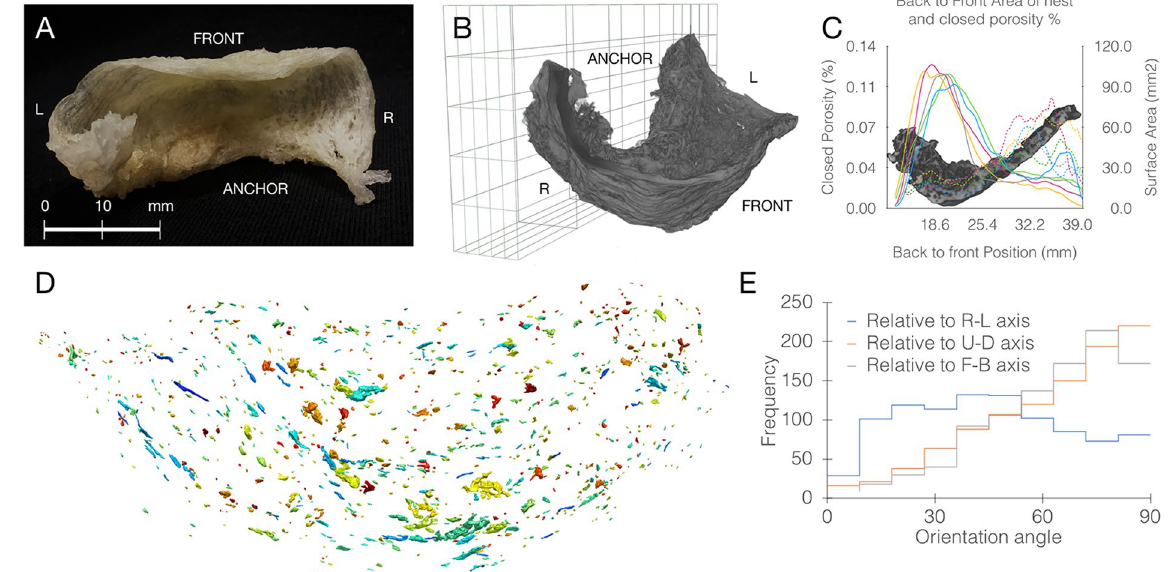
Figure 1. 3D characterization of the edible swiftlet nest. ( A ) A representative nest photograph showing the overall structure with orientation, bar = 20 mm. ( B ) 3D model of the nest, reconstructed from the μ CT scan, oriented relative to the wall to which it is anchored. ( C ) Similarity between nests at the microstructure level. The distribution of two representative properties, surface area and percentage of closed pores revealed by the μ CT scan, across the nest in the back-to-front direction. A collection of n = 5 nests showing that they exhibit the same pattern. Continuous lines are surface area and dotted lines are percentage of internal closed porosity. ( D ) Multi label pore mask of closed pores in the nest. ( E ) Quantitative analysis of pore orientation, demonstrating that the pores are approximately orthogonal to the up-down (U-D) and front-back (F-B) axes, and are aligned with the right-left (R-L) axis, as expected of a horizontally-biased structure. D and E were performed on one of the